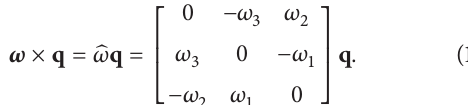
digit. There are interdigital ligaments (cruciate ligament)